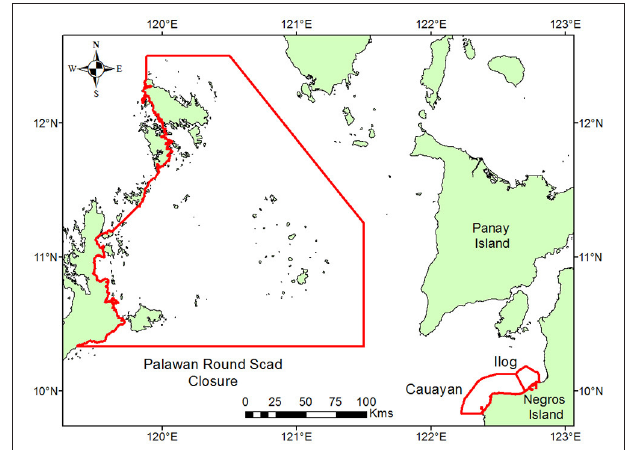
FIGURE 2 | Reference map of the Palawan Round Scad and Cauayan and Ilog municipal water closures in the